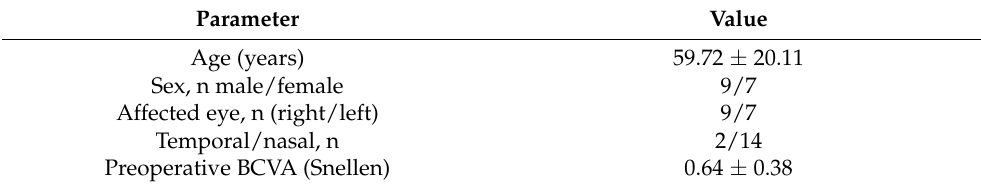
Table 1. Clinical characteristics of patients.